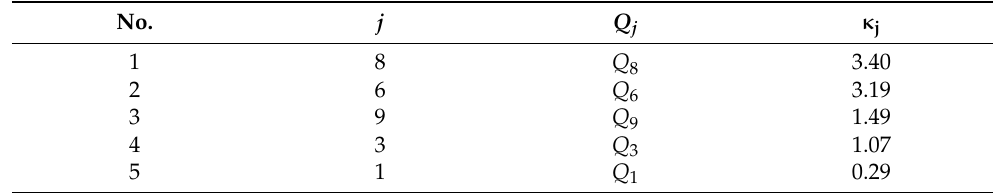
Table 10. A Ranking List of the Dominant Nodal Reactive Powers when the Index κ is Adopted as Criterion.